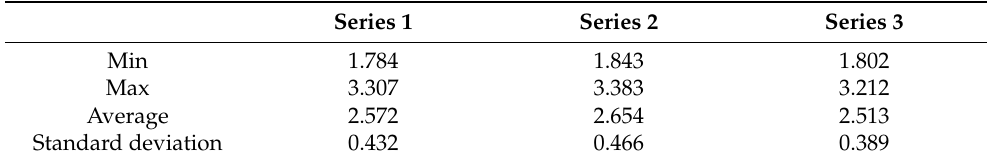
Table 7. Ultrasonic measure of joint quality R for the first three measurement runs (the complete set of results are available in the Appendix A, Table